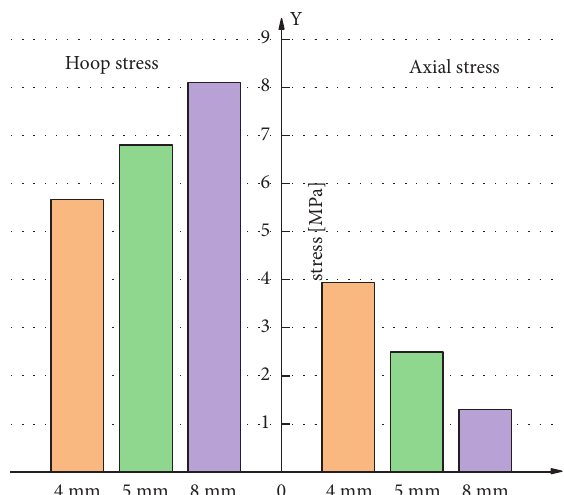
Figure 16: Stress of different section